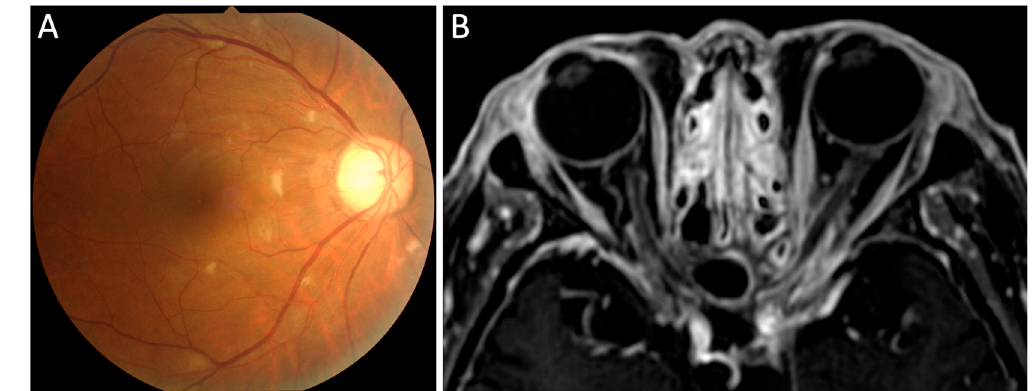
Figure 5. Retinopathy and optic perineuritis in patients with RPC. Fundus photograph shows cotton-wool spots in the retina ( A ). Gadolinium-enhanced T1-weighted MRI with fat suppression shows the “tram-track” enhancement of the left optic nerve sheath ( B ).